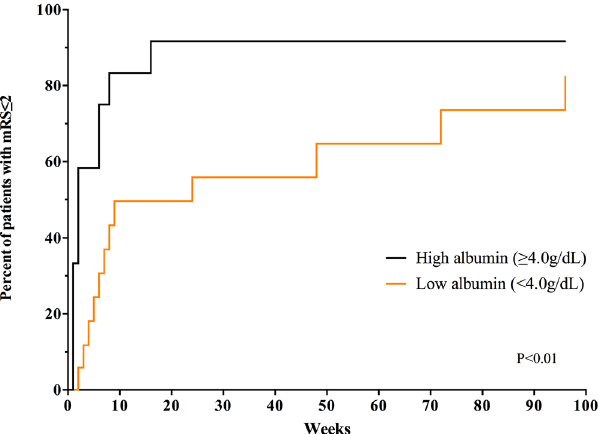
Figure 1. Long-term outcome according to pretreatment serum albumin in patients with autoimmune encephalitis. Kaplan-Meier analysis shows that patients with low albumin ( < 4.0 g/dL) exhibit significantly delayed recovery to activities of daily life without assistance (modified Rankin Scale ≤ 2) (P <